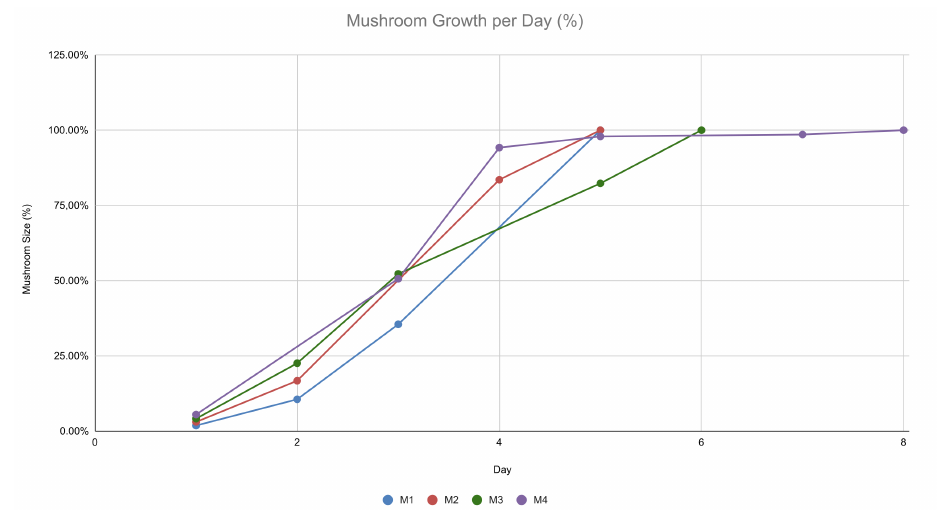
Figure 11. Comparing the percentage of the growth rate of